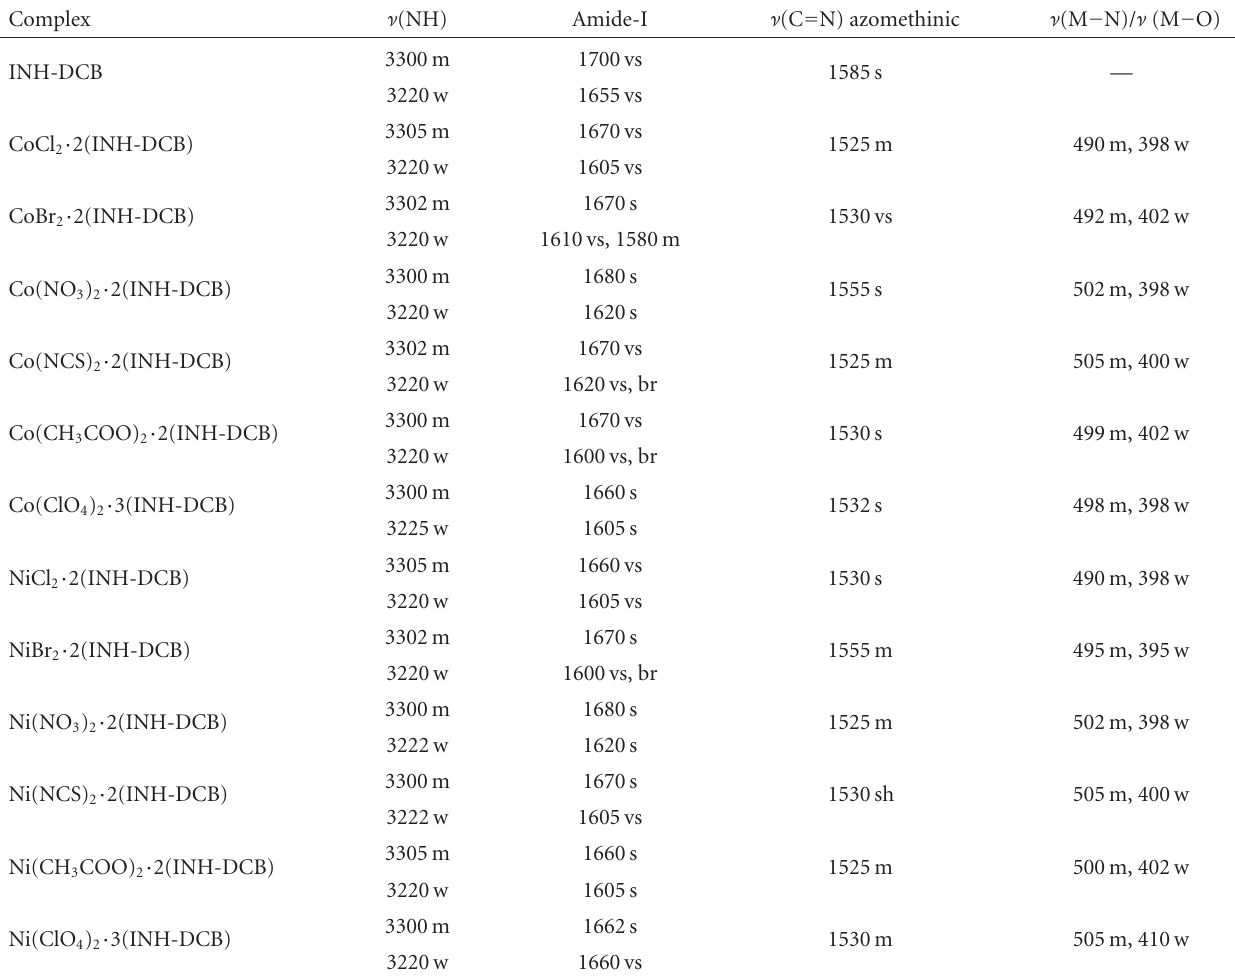
Table 2: Infrared absorption frequencies (cm − 1 ) of Co 2+ and Ni 2+ complexes